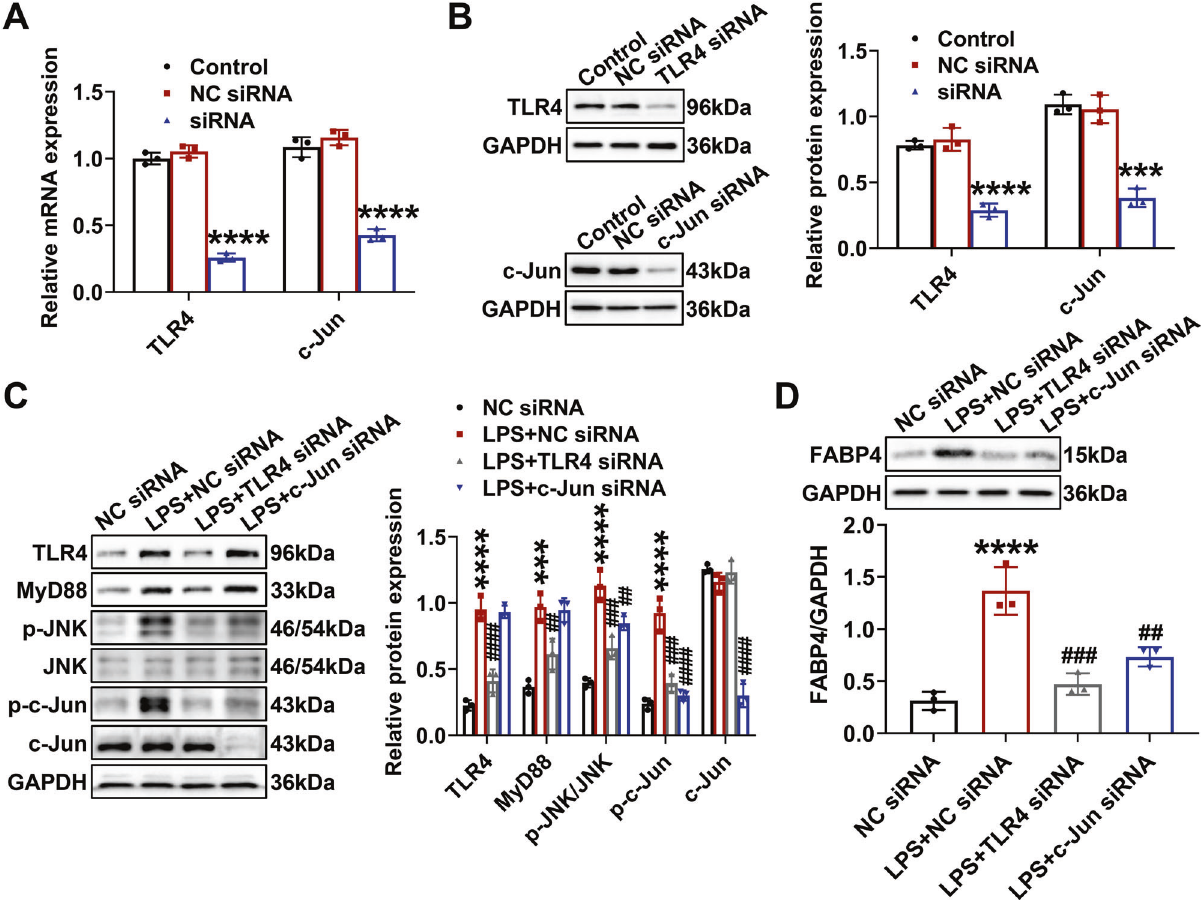
Fig. 7 Upregulation of FABP4 was mediated by TLR4/c-Jun signaling activation in LPS-stimulated TCMK-1 cells. TCMK-1 cells were transfected with negative control (NC) siRNA, TLR4 siRNA, or c-Jun siRNA for 24 h and then treated with 100 μ g/ml LPS for another 24 h. The knockdown ef fi ciencies of TLR4 siRNA and c-Jun siRNA in TCMK-1 cells were evaluated by ( A ) quantitative real-time PCR analysis and ( B ) western blot analysis. C Western blotting and densitometry quanti fi cation of TLR4, MyD88, p-JNK, JNK, p-c-Jun, and c-Jun in TCMK-1 cells. D FABP4 protein expression detected by western blotting and quanti fi ed by densitometry in TCMK-1 cells. All data are represented as mean ± SD ( n = 3); *** P < 0.001, **** P < 0.0001 versus NC siRNA; ## P < 0.01, ### P < 0.001, #### P < 0.0001 versus LPS + NC